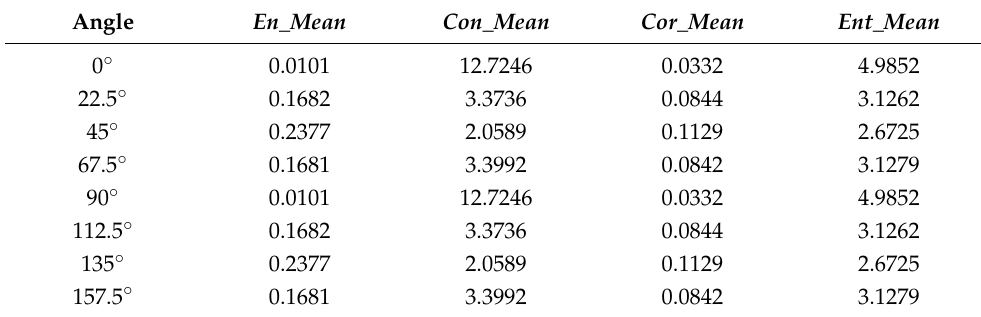
Table 7. Results of traditional GLCM with different angles.